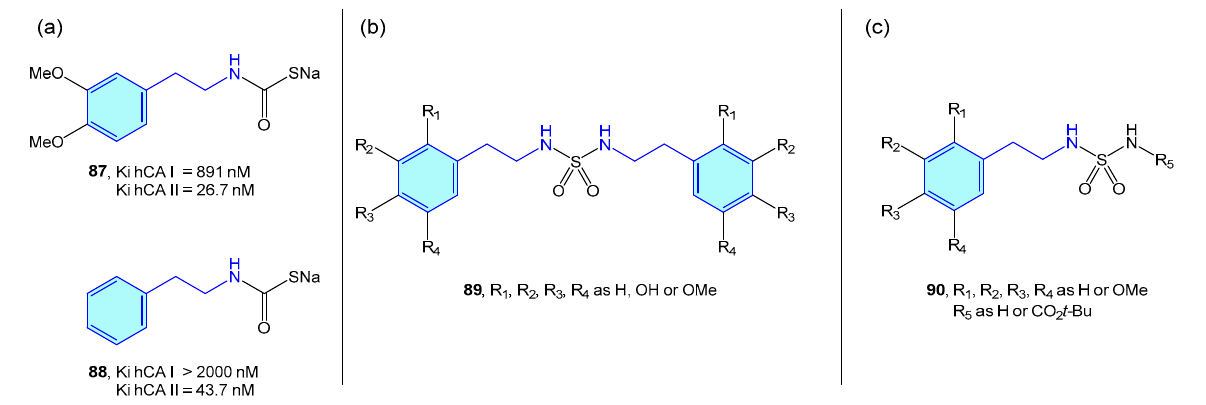
Figure 8. 2-Phenylethyl-based CA ligands. Figure 8. 2‑Phenylethyl‑based CA ligands.